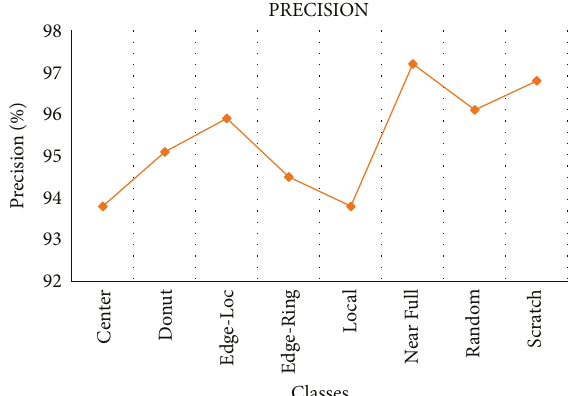
Figure 8: Graphical plot of ShuffleNet-v2-CNN’s precision performance.